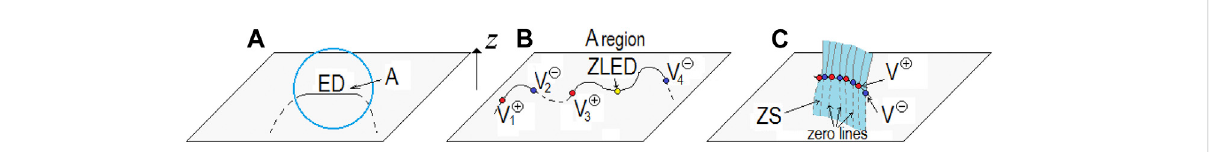
FIGURE 10 Manifestationsofzero-lines(ZLs)andzero-surfaces(ZSs)regardingtheirpositionswithrespecttotheobservationplane(horizontalplane): (A) ZL,or its segment, lies completely in the observation plane (non-generic case); (B) ZL crosses the observation plane several times; (C) ZS is decomposed into a set of adjacent ZL crossing the observation plane.